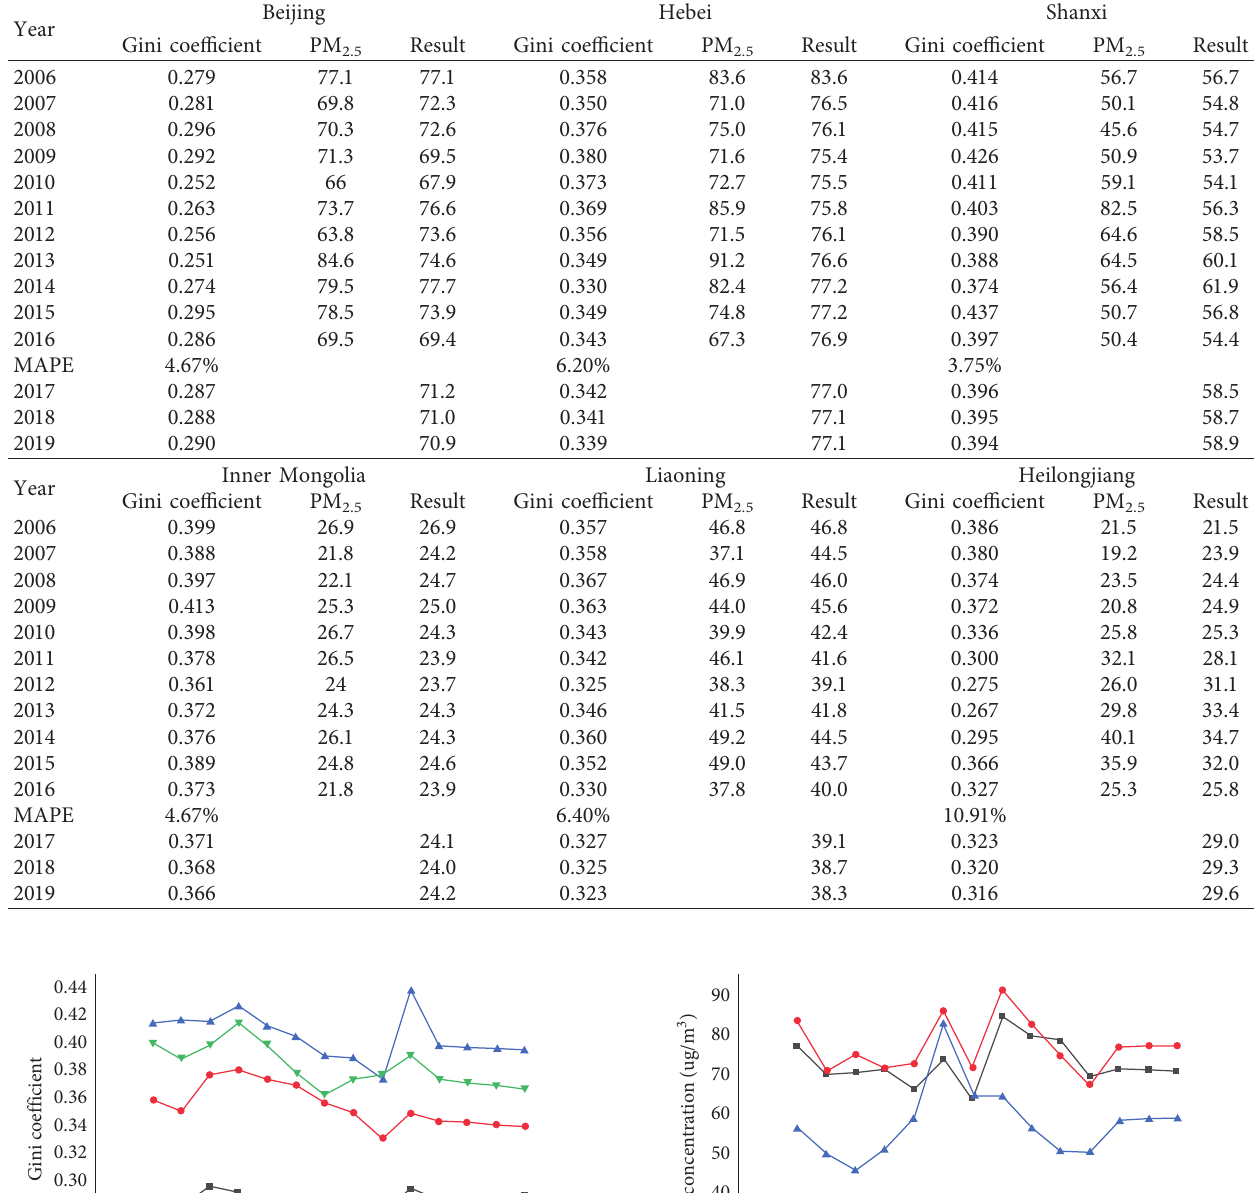
Table 4: Fitting results of the PM 2.5 concentrations in North and Northeast China.